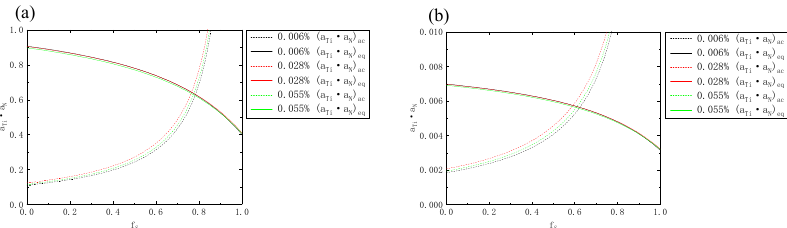
Figure 19. Relationship between MnS activity product and solid fraction of steel with different Ti content ( a ) liquid phase; ( b ) solid phase.